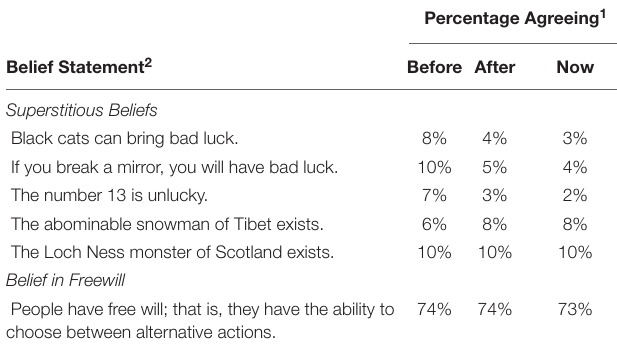
TABLE 3 | Percentage of participants endorsing agreement about superstitious beliefs and the belief in freewill ( N =